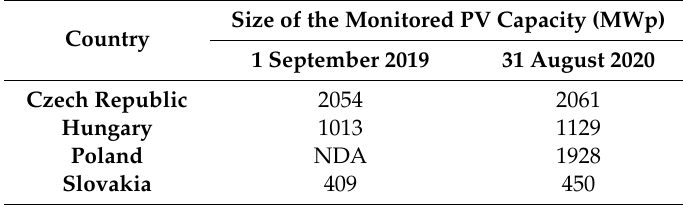
Table 2. The monitored PV capacities of the Visegrad countries [83,84].